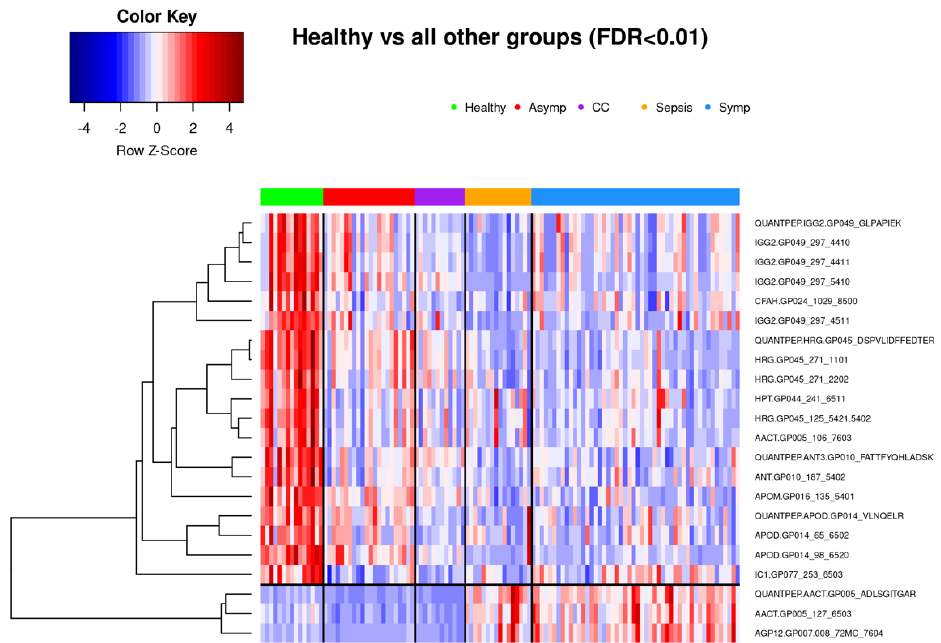
Figure 5. Twenty-two biomarkers that achieve FDR < 0.01 in differential expression analysis between healthy controls and all four of the other phenotype groups separately. Seventy-seven biomarkers achieve FDR < 0.05; a more conservative threshold was chosen for clarity of the heatmap. Subjects are clustered into phenotype groups column-wise and hierarchically clustered row-wise. Row-wise Z-scores determine the color of each cell.